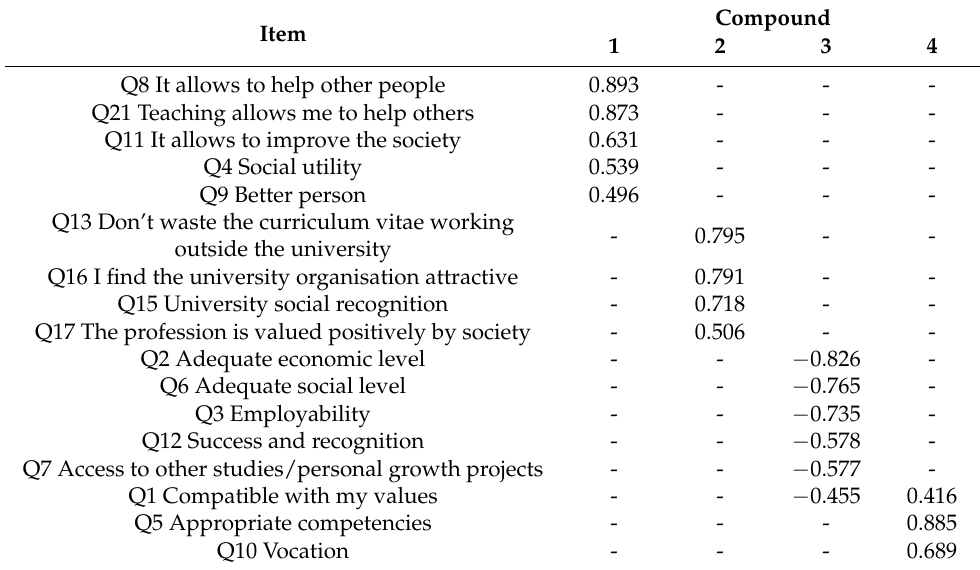
Table 5. Grouping of items by factors according to rotated component matrix 1 .